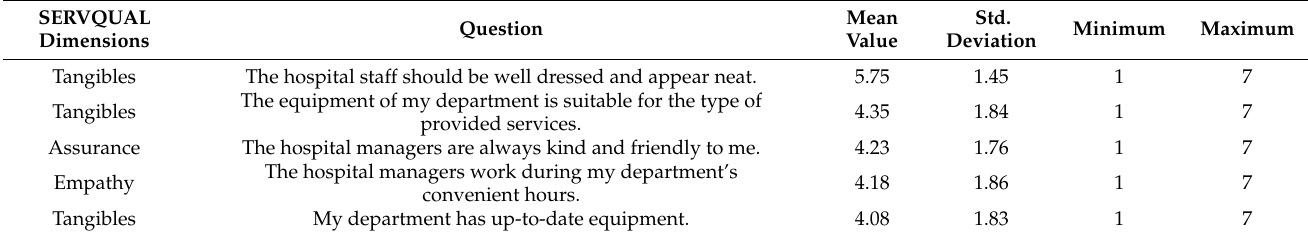
Table 4. The five (5) questions with the highest score.